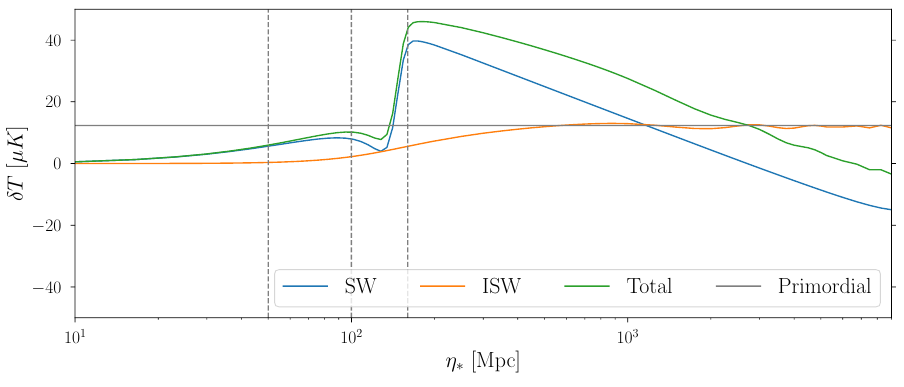
Figure 3 . Temperature of the central pixel (green) of a hotspot originating from a heavy particle for g = 1 , based on eq. (3.18) with ˆ n = ˆ n . This is done by summing the SW (blue) and the HS ISW (orange) effects, with the Doppler effect being subdominant. The green line shows how the observed anisotropy varies as a function of “size” of the hotspot, characterized by the size of the comoving horizon at the time of particle production, η . The gray line shows the going rate of the ∗ temperature fluctuation due to only the standard primordial quantum fluctuations (i.e., without any subhorizon effect), determined by 1 × g h ζ 2 i 1 2 × 2 . 7 K. Here h ζ 2 i 1 2 is given below eq. (3.8) q q 5 2 and the factor 1 / 5 characterizes a flat superhorizon transfer function. The dashed vertical gray lines show the benchmark choices for the hotspot size chosen in the subsequent discussion. For η ∗ & 6600 Mpc, the central temperatures associated with the heavy particles become negative since the (now negative) SW effect dominates over the (positive) ISW effect, and consequently, they give rise to cold spots as opposed to hot